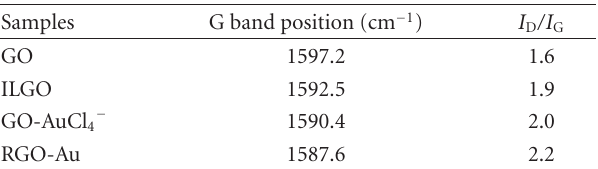
Figure 6: Raman spectrum of (a) GO, (b) ILGO, (c) GO-AuCl 4 − , and (d) RGO-Au. Table 1: The position of G band and values of I D /I G obtained from Raman spectra.